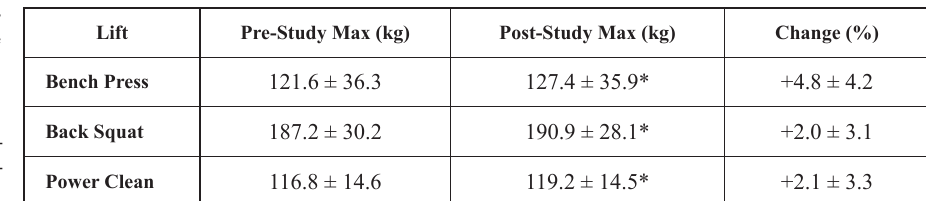
Note. *Significant differen- ces from respective pre- study value ( p <